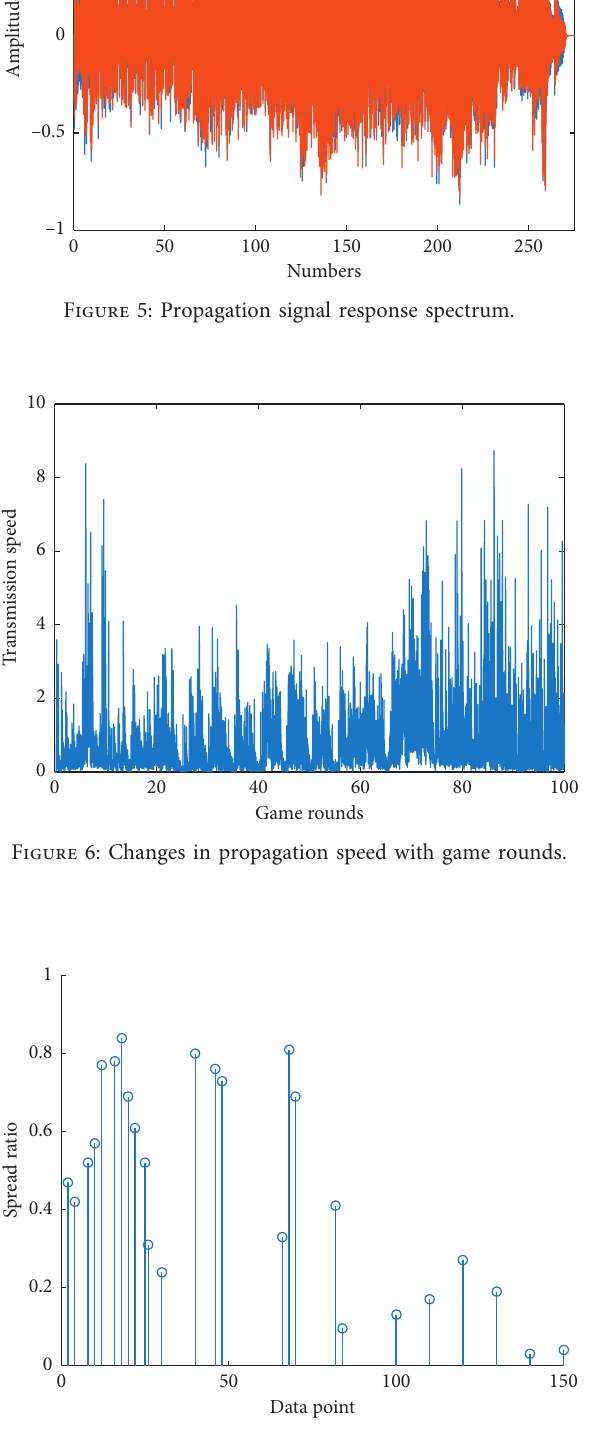
Figure 7: Dependence of model data points and propagation